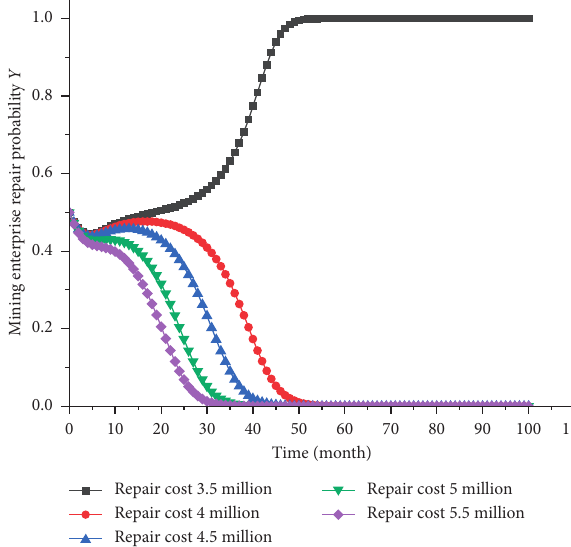
Figure 2: Initial state probability curve of the tripartite game between governments at all levels and mining enterprises.